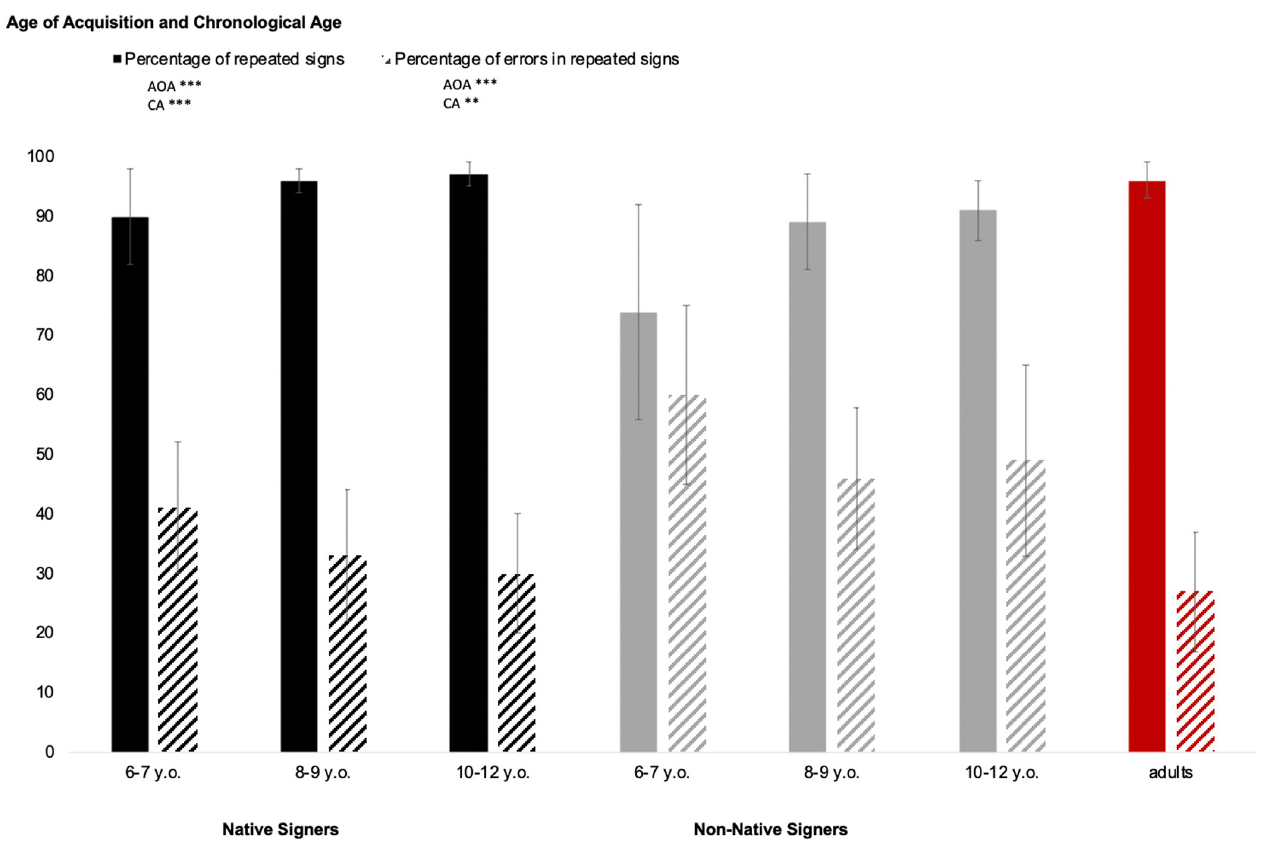
Fig 2. Percentage of repeated signs and percentage of errors in repeated signs according to age of acquisition and chronological age. Adults are considered as the control group ( ��� p < .001; �� p < .01; � p < .05; n.s. p > .05).